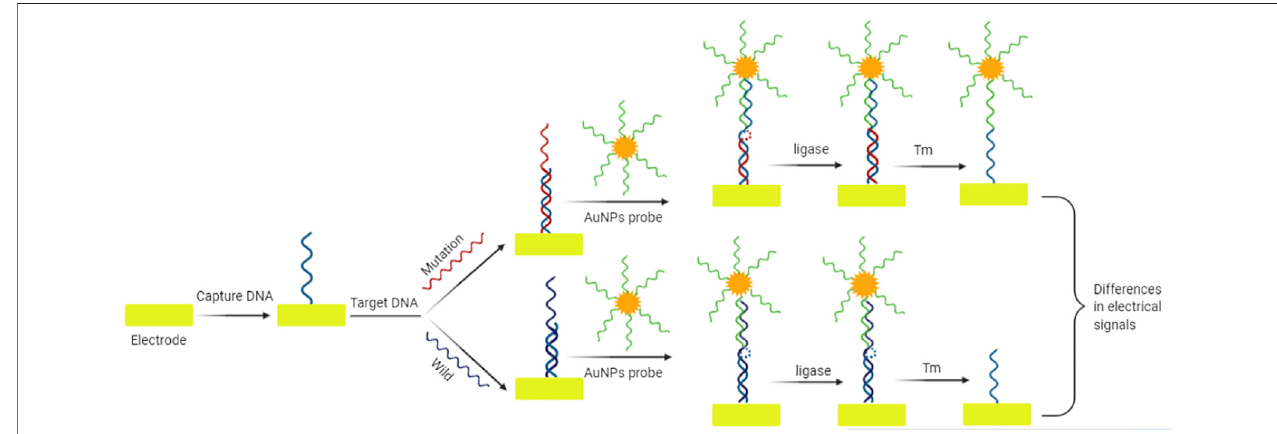
FIGURE 2 | Schematic diagram of electrochemical sensor for mutation detection based on ampli fi cation effect of E. coli DNA ligase and AuNPs. The gap between thecaptureprobeandAuNPsprobeisclosedby E.coli DNAligaseonlyinthesequenceharboringmutation.Theresultingdifferencesinelectricalsignalscanbeusedfor the mutation identi fi